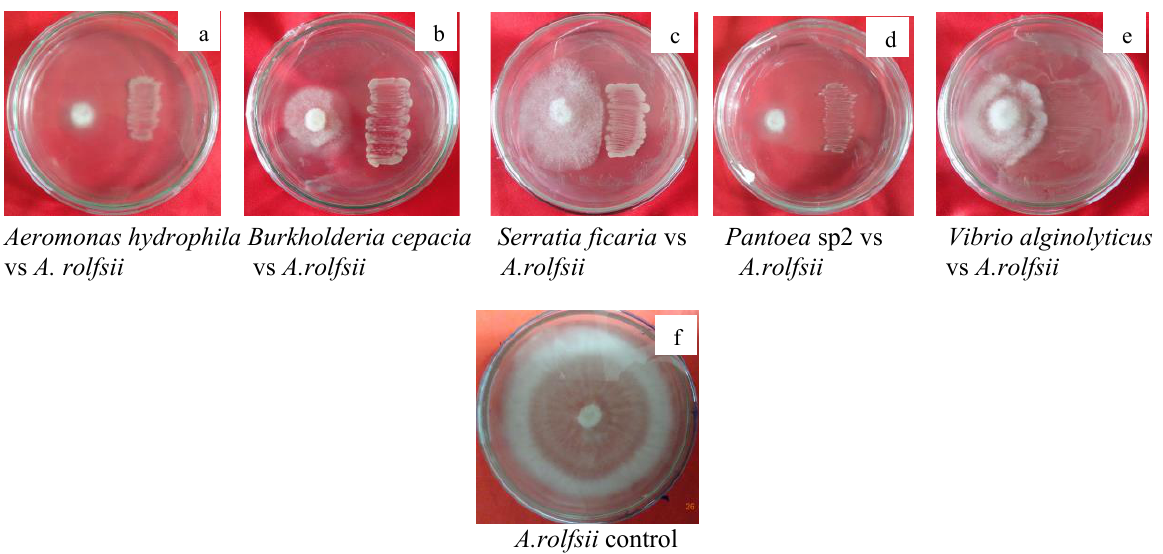
Figure 1: In vitro antagonism of Plant Growth Promoting Rhizobacteria isolates against Athelia